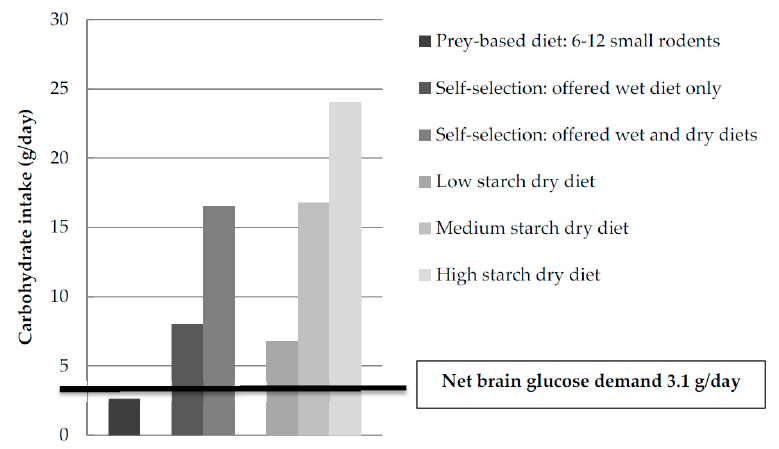
Figure 4. Carbohydrate intake following consumption of a prey-based diet (NFE